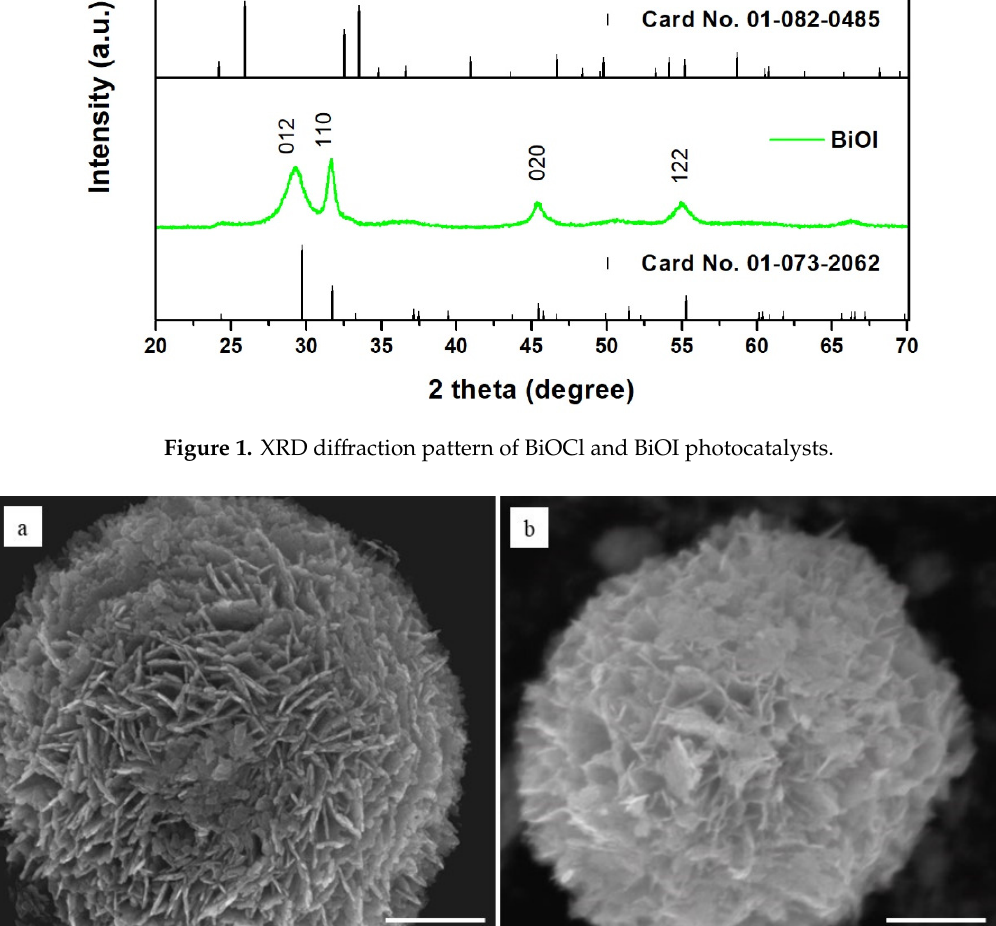
Figure 1. XRD diffraction pattern of BiOCl and BiOI photocatalysts.